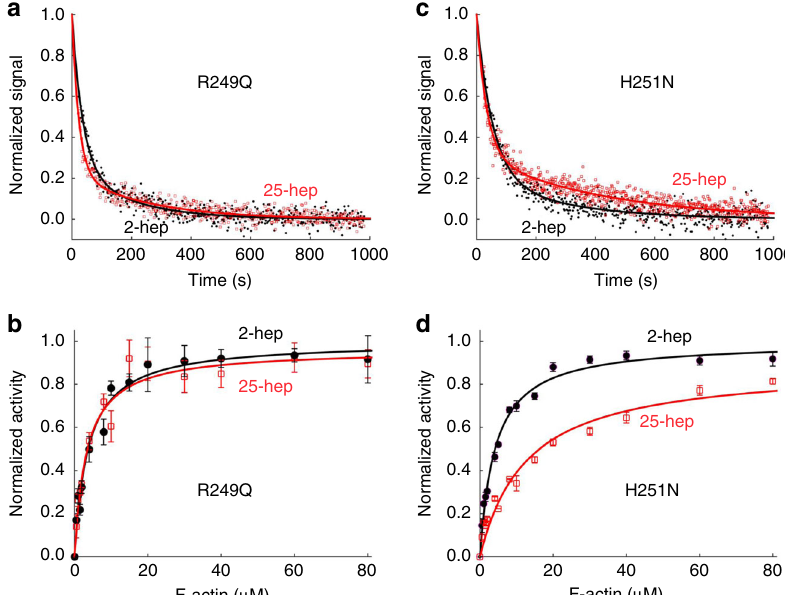
Fig. 4 Effect of mesa mutations R249Q and H251N on HMM ATPase kinetics. In all cases, black solid line and fi lled circles are 2-hep HMM data; red solid line and empty squares are 25-hep HMM data. a Mant-nucleotide single turnover kinetics for R249Q 2-hep HMM and 25-hep HMM. b Actin-activated ATPase data for R249Q 2-hep and 25-hep HMM. c Mant-nucleotide single turnover kinetics for H251N 2-hep and 25-hep HMM. d Actin-activated ATPase data for H251N 2-hep and 25-hep HMM. a , c show representative data from one preparation each. Each of panels b and d are combined data from three independent preparations of HMMs with three experimental replicates for each preparation. Each point is an average with the error bar representing the SEM. Source data are provided as a Source Data fi